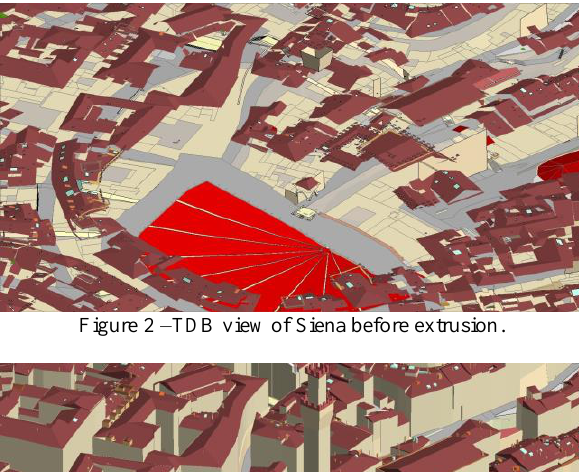
Figure 2 –TDB view of Siena before extrusion.